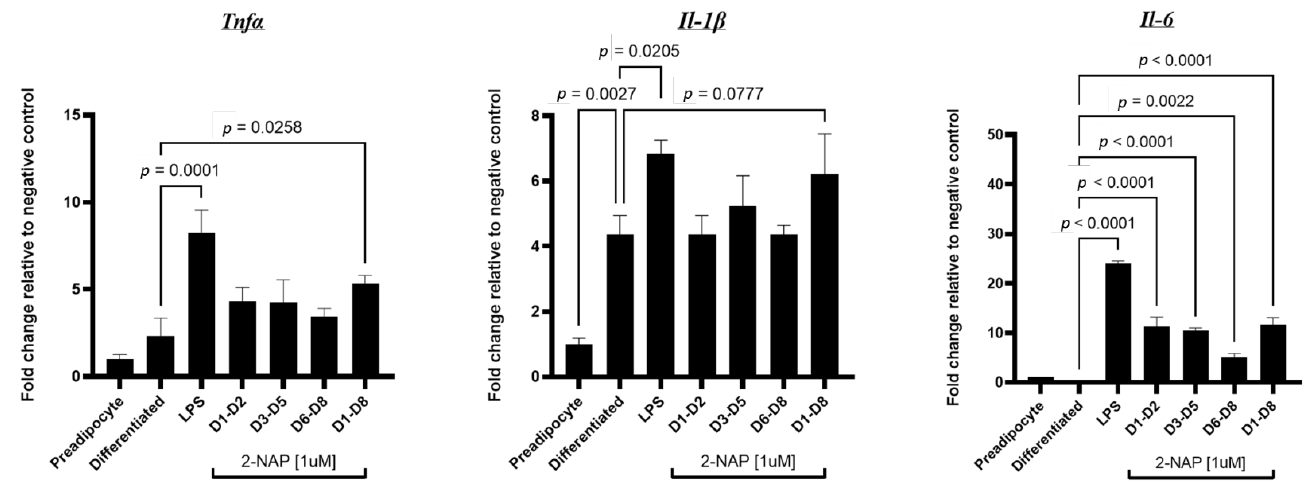
Figure 5. Chronic 2-NAP exposure increases the expression of inflammatory genes in 3T3-L1 cells. Relative mRNA expression of inflammatory genes ( Tnf α , Il-1 β , and Il-6 ) in 3T3-L1 adipocytes chroni- cally treated with 1 µ M 2-NAP as indicated. LPS (1 ng/mL) was used as a positive control. Upon experimental termination, mRNA was extracted and relative gene expression was then determined by RT-PCR ( n = 4). The values shown represent the mean ± SEM. A p -value of p < 0.05 indicates statistical significance between two groups.